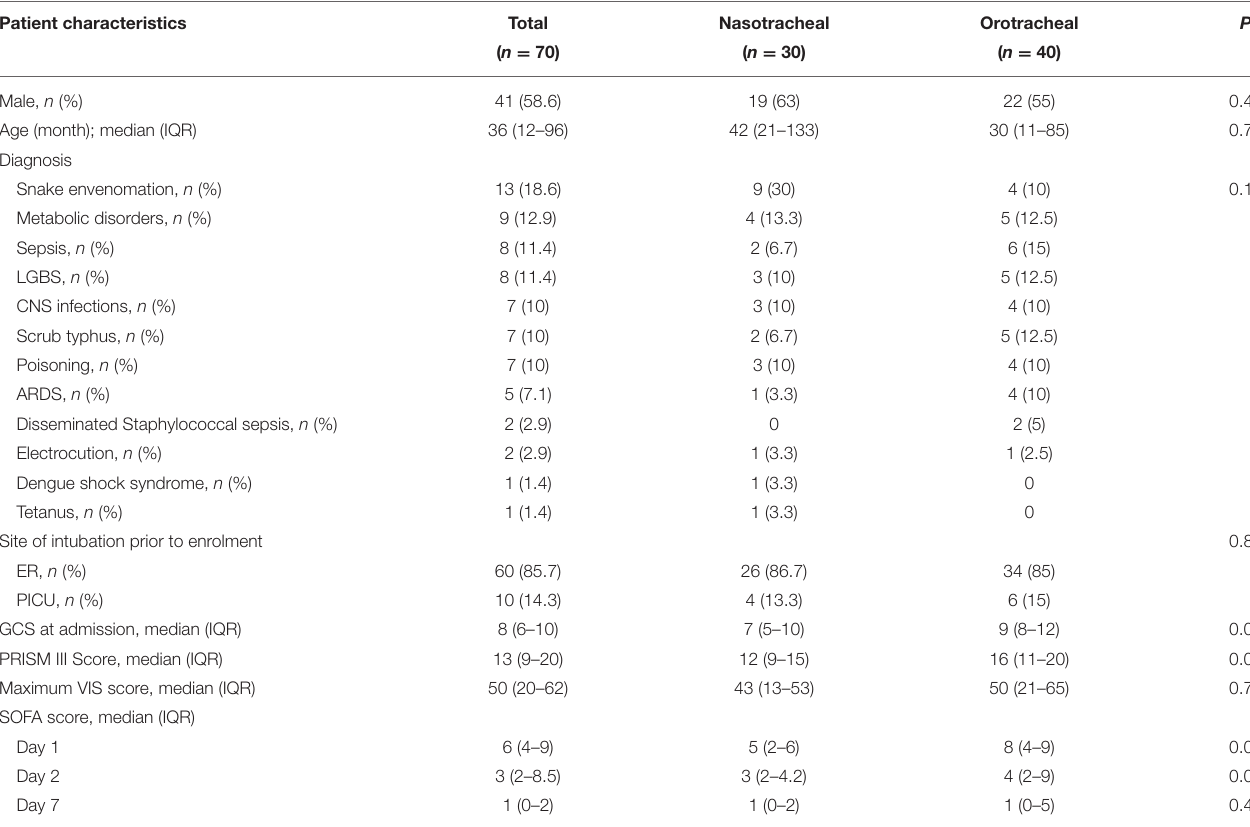
TABLE 1 | Baseline characteristics and severity scores among children in nasotracheal and orotracheal intubation groups. Patient